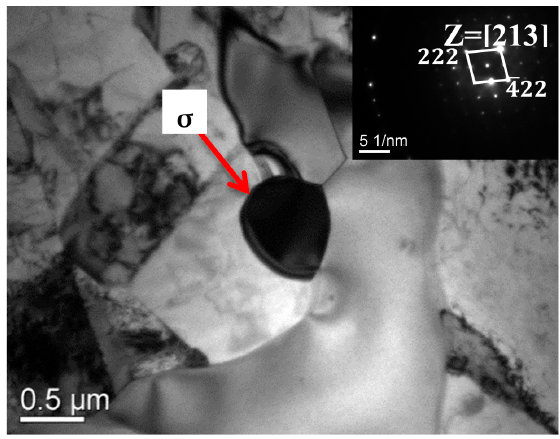
Figure 4. ( a ) SEM micrographs; and ( b ) energy dispersive spectroscope (EDS) analysis of precipitates and secondary austenite in 2707 HDSS deformed at 900 °C and 0.01 s − 1 .